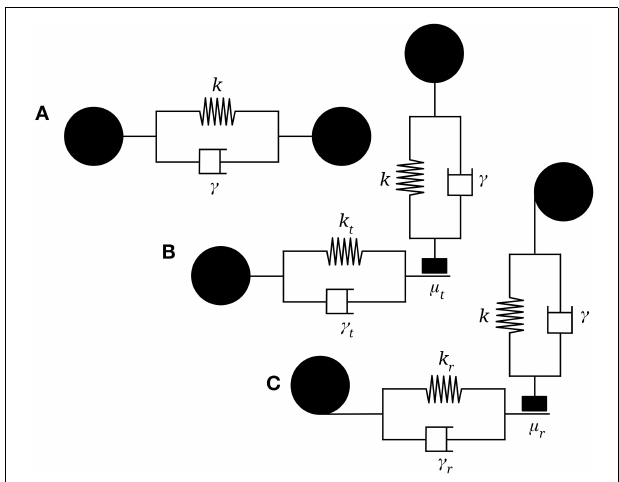
FIGURE 2 | Contact laws used in the discrete element model. Interactions are characterized by (A) normal, (B) tangential and (C) rolling